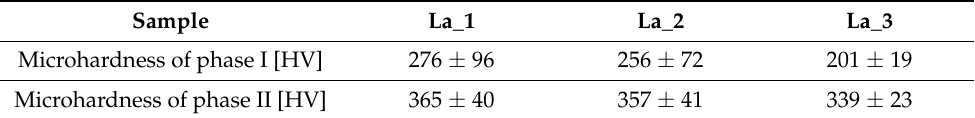
Table 4. Average values and errors of microhardness of the Fe-B-La-Al alloy ingots. Sample